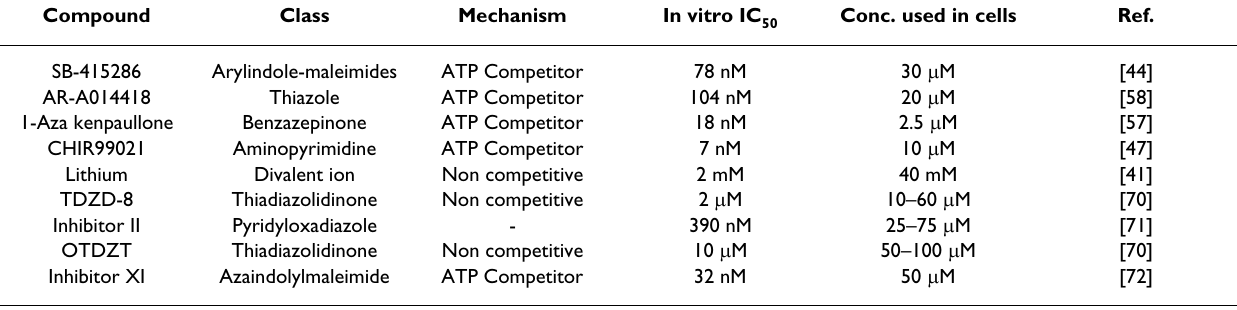
Table 1: GSK-3 inhibitors used in this study Compound